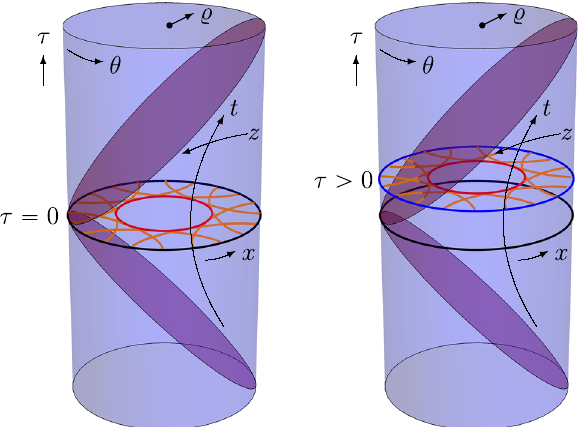
Fig. 1 Each of these solid cylinders is a Penrose diagram for AdS 3 , covered in full by the global coordinates ((cid:3),τ,θ) , but only in part by the Poincaré set ( t , x , z ) . The latter coordinates span the wedge between the AdS boundary z = 0 ( ↔ (cid:3) = π/ 2), at the surface of the cylin- der, and the Poincaré horizon z → ∞ , shown as the purple disks tilted at 45 ◦ . Each cylinder displays an example of a bulk curve within the Poincaré wedge (a circle, shown in red), together with its tangent geodesics (in orange), which in the global description allow the curve to be reconstructed hole-ographically. On the left, the curve is at fixed global time τ = 0 ( ↔ t = 0). In this case, complete reconstruction of the curve should be possible using data in the Minkowski CFT 2 dual to the Poincaré wedge, because all of the tangent geodesics are inside the wedge. On the right, the curve is at constant τ > 0 ( ↔ t (cid:7)= constant), and we see that it contains a segment whose tangent geodesics exit the wedge. Even though this segment is part of Poincaré AdS, it cannot be reconstructed in the Minkowski CFT 2 using the standard hole-ographic